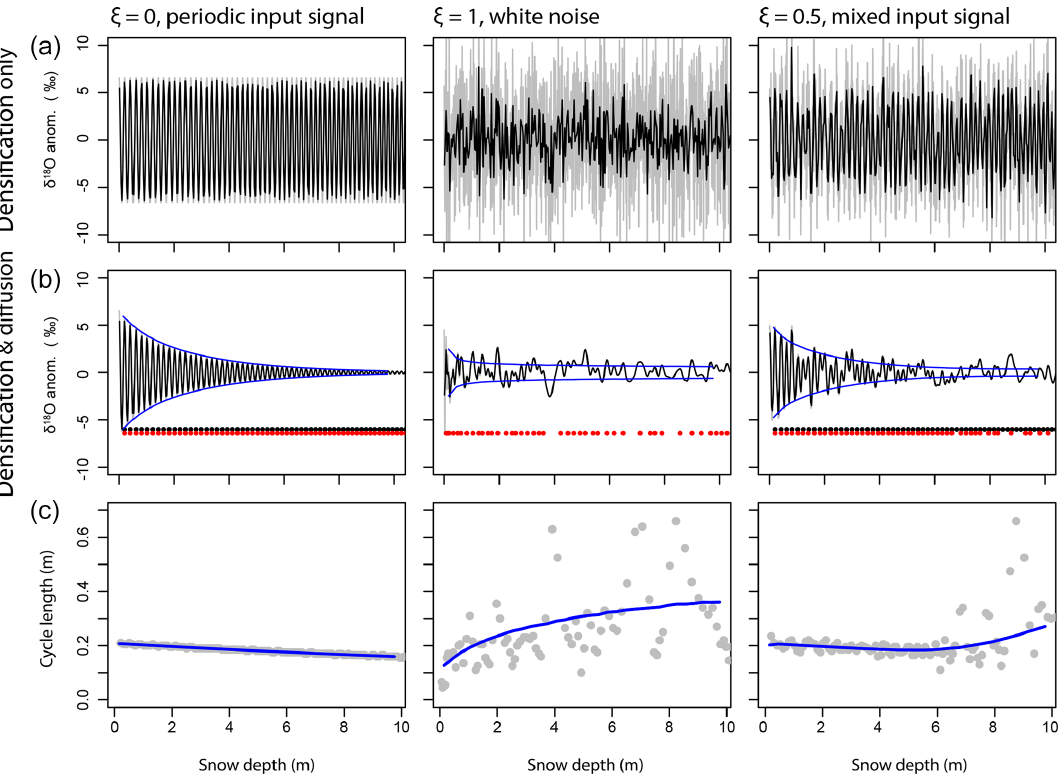
Figure 6. Illustrative examples of the effect of noise and firn diffusion on the cycle length and amplitude for three input time series ( ξ = 0 , 1 , 0 . 5). (a) Input signal after densification. (b) Signal after densification and diffusion. The raw (2mm resolution) data (grey) and 2cm averages (black) mimicking a typical sampling resolution are shown. In addition, the mean expected amplitude from the Monte Carlo simulations (blue), the positions of the expected maxima of a purely periodic signal (black dots) and the positions of the actual maxima (red dots) are provided. (c) Mean expected cycle length (blue) and actual distance (grey) between pairs of maxima (or